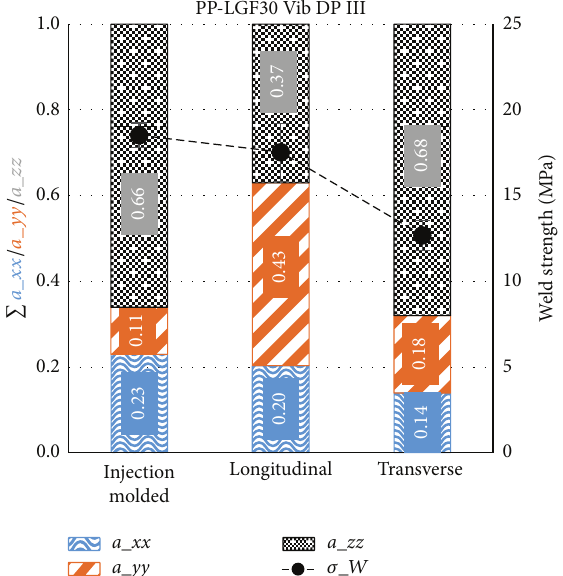
Figure 28: Fiber orientation and weld strength in vibration welding of PP-LGF30 for different initial fiber orientations.